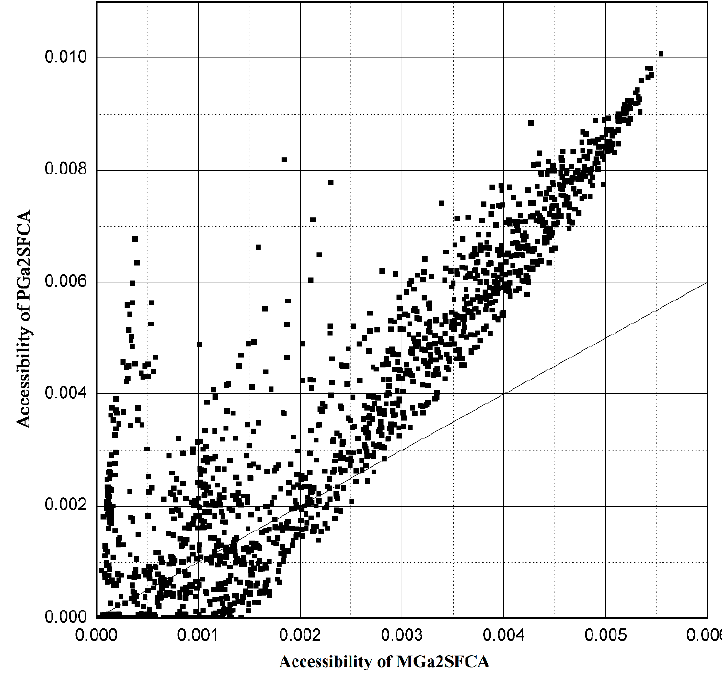
Figure 7. Accessibility comparison of the PGa2SFCA method and the MGa2SFCA method.